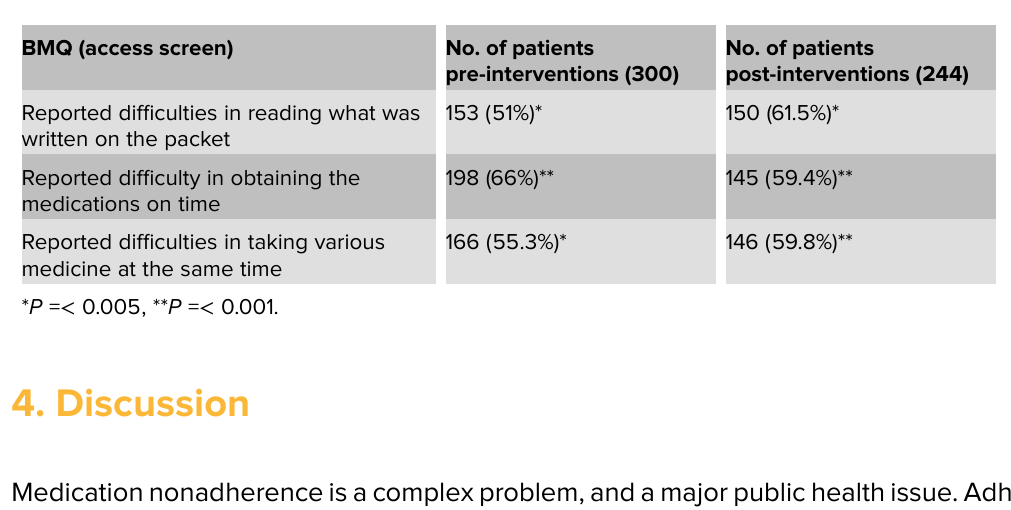
TABLE 6: Frequency of patient’s responses to BMQ (access